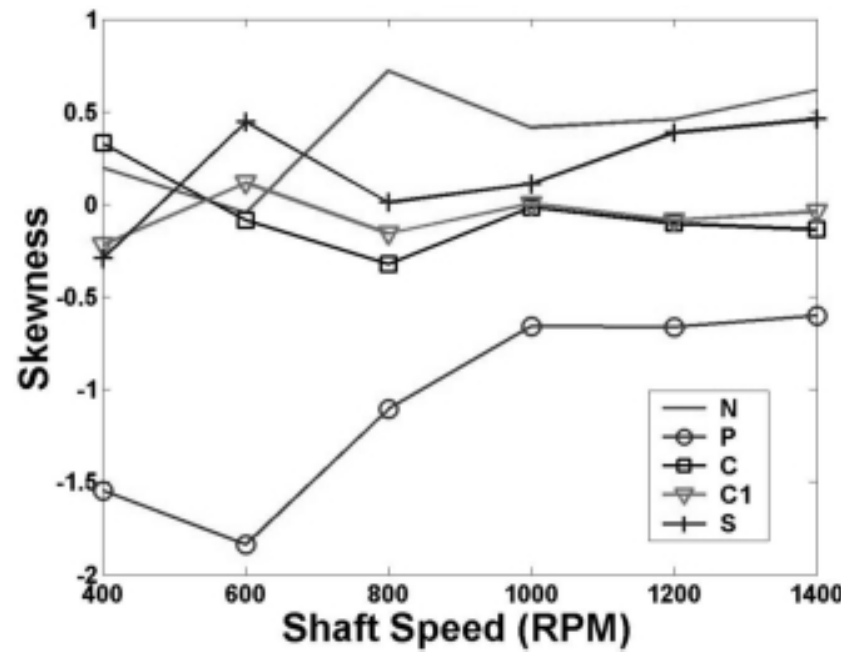
Fig. 2. Skewness of the velocity signal as a function of the rotating shaft speed, load